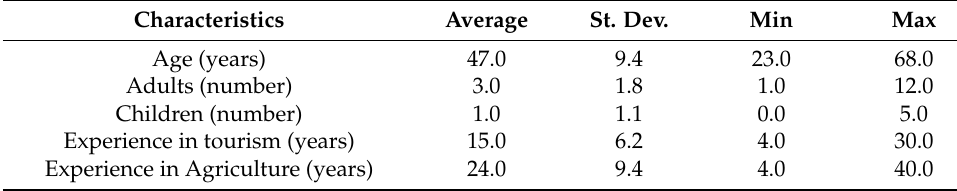
Table 2. Demographic characteristics of Owner-Managers.